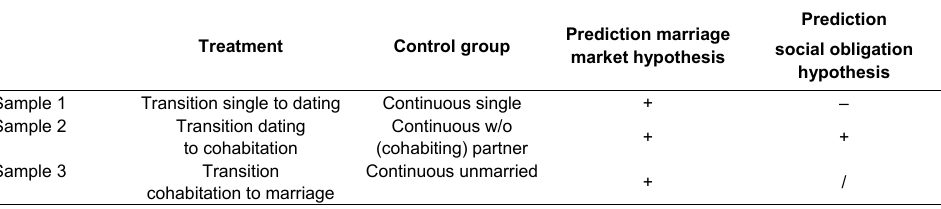
Summary estimation samples and theoretical predictions Treatment Control group